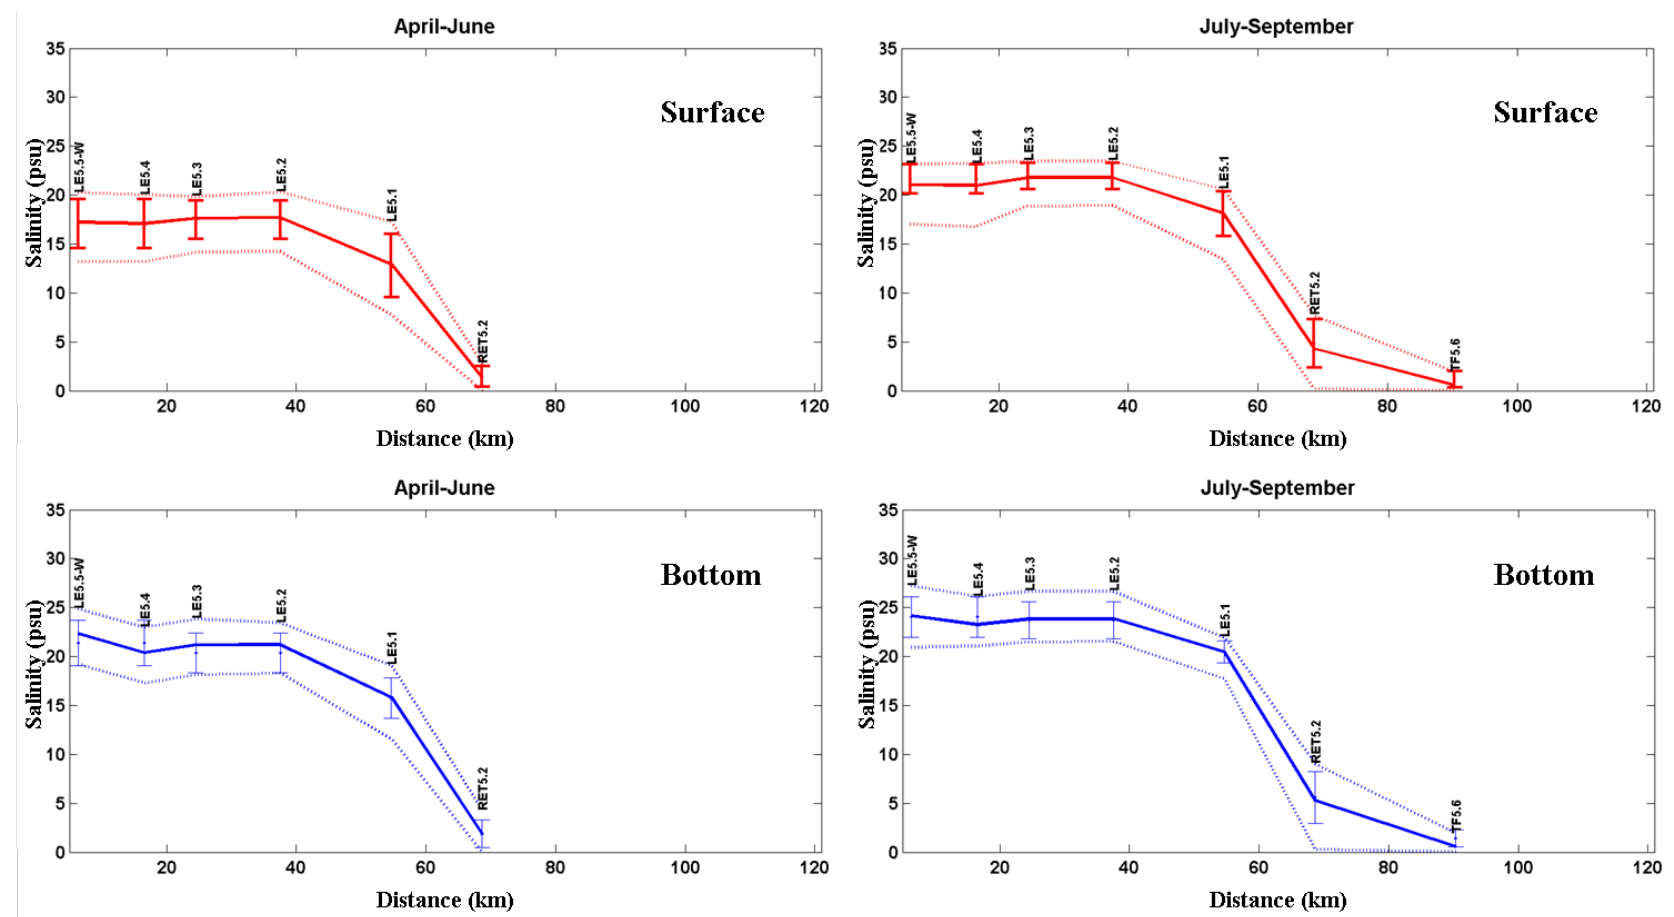
Figure 6. Comparison of salinity intrusion (the bar represents one standard deviation, and the upper and lower bounds are the maximum and minimum salinity).